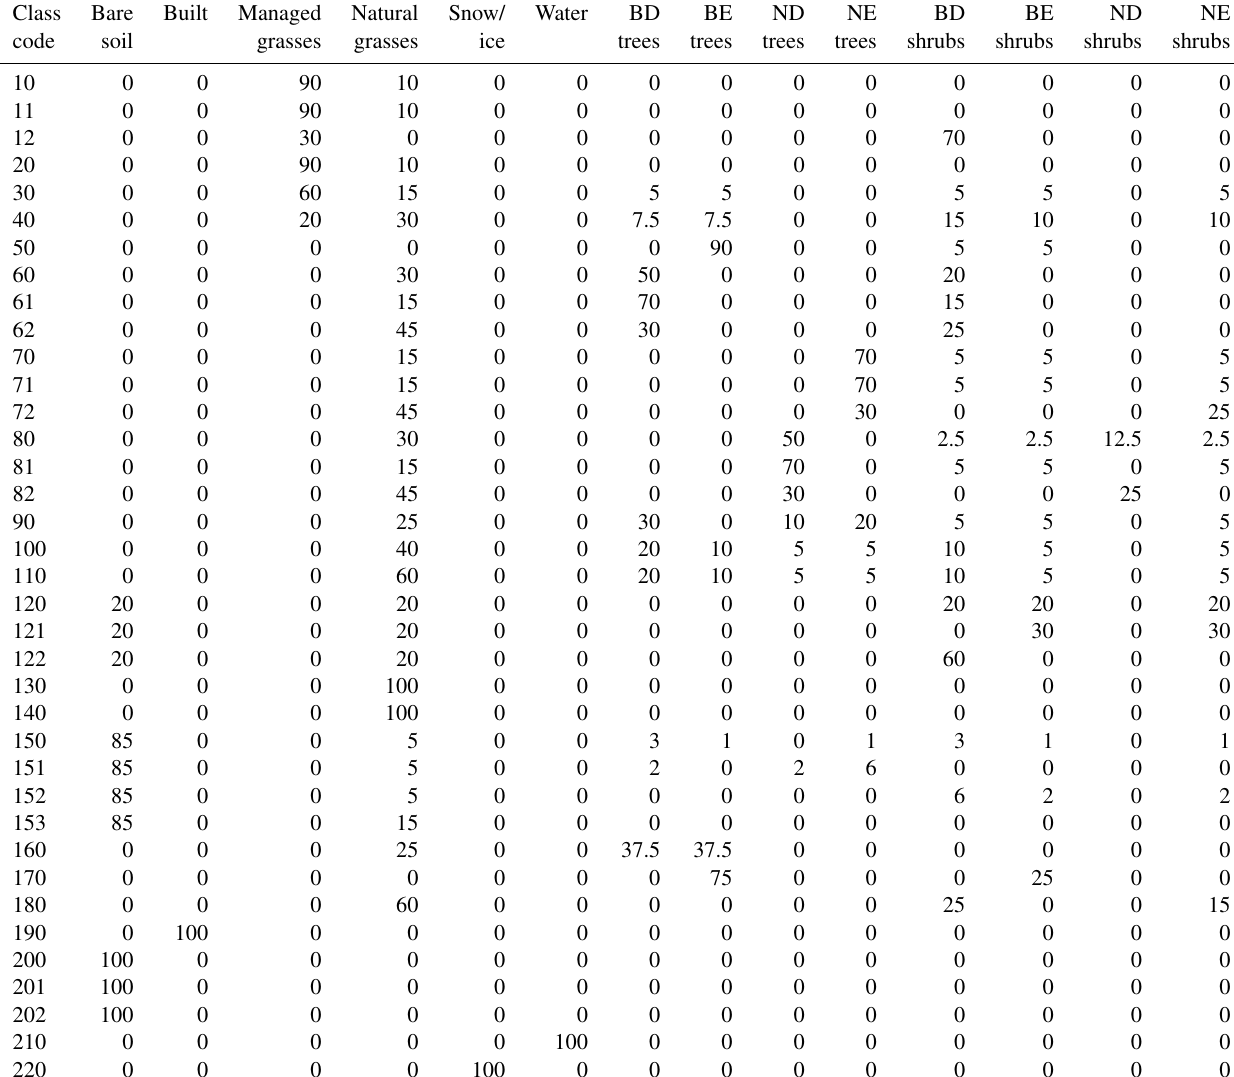
Table A2. Percentage PFT composition by class based on the most recent update to the global cross-walking table.